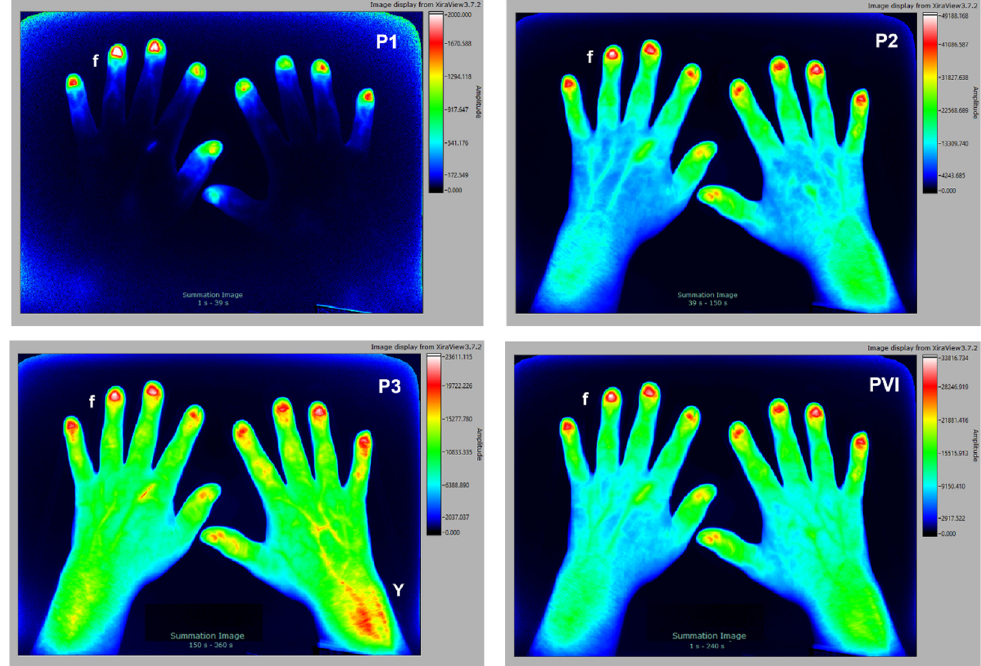
Figure 1. The 51 y/o male volunteer without clinical signs of inflammation. Signal enhancement is seen in the fingertips (f) and a slight signal enhancement in the muscle–tendon junctions (Y).